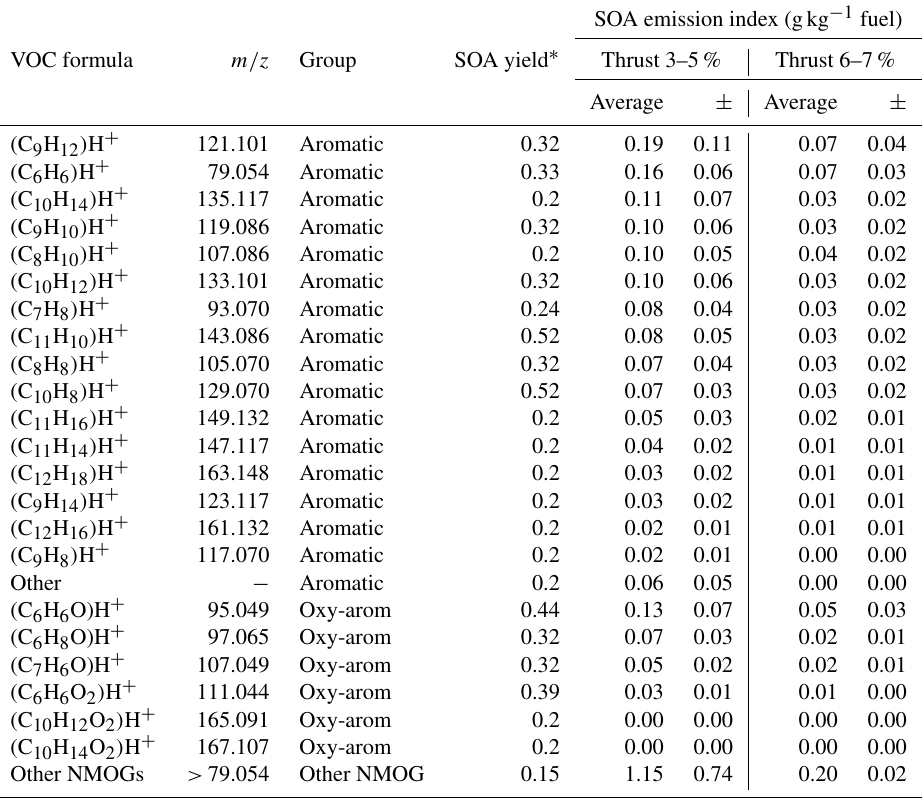
Table 2. Precursor OGs, their corresponding functional group and protonated m/z , SOA yield coefficients ∗ from literature, and average SOA EI estimated for different